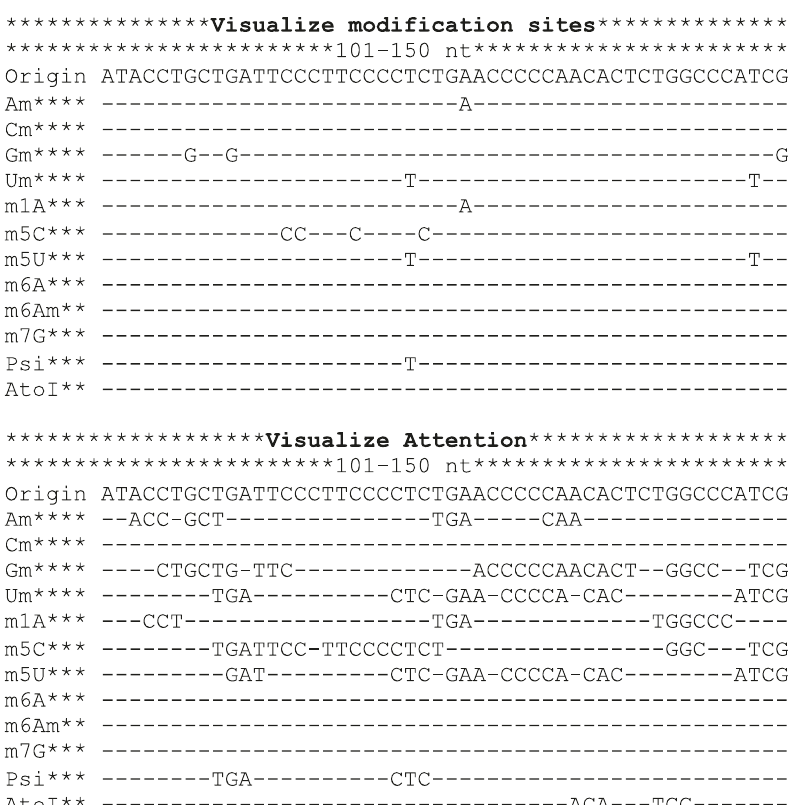
Fig. 4 Output of the MultiRM web server. The web server supports site prediction and result interpretation for twelve widely occurring RNA modi fi cations (m 6 A, m 1 A, m 5 C, m 5 U, m 6 Am, m 7 G, Ψ , I, Am, Cm, Gm, and Um) from RNA (or DNA) sequences. The fi gure shows the predicted RNA modi fi cation sites (upper panel) and the sequence components that contributed most to the positive predictions (lower panel) between the 101st and 150th nucleotides of an input sequence. The predicted probabilities, statistical signi fi cance, and attention scores of RNA modi fi cations can all be downloaded as separate fi les from the web server. At the 123 rd nucleotide, multiple RNA modi fi cations originated from U were predicted with a p -value less than 0.05, which, to some degree, re fl ected the associations among different RNA modi fi cations unveiled previously (see Fig.